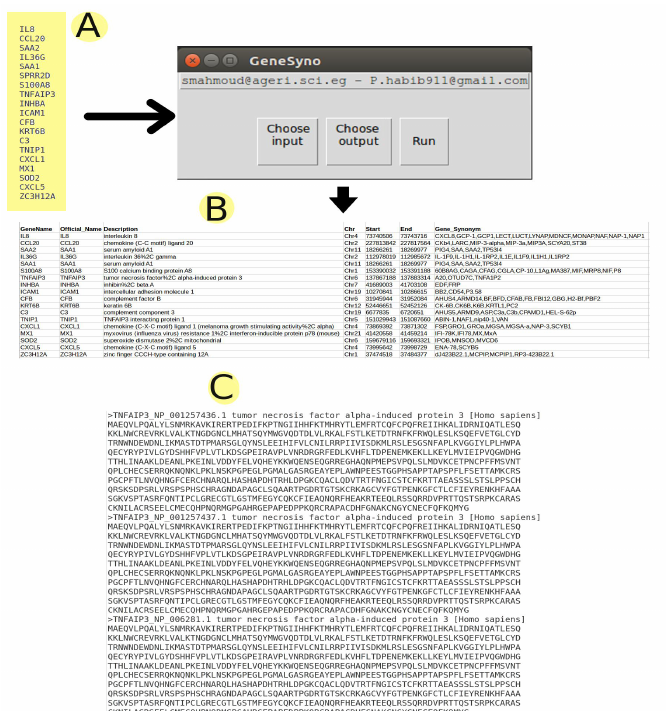
Figure 1 : Example of GeneSyn input and outputs. If a list of names of human genes is given in text format (A), GeneSyno can produce a table containing all gene information in tab delimited format (B) and protein sequences in FASTA formats (C) .